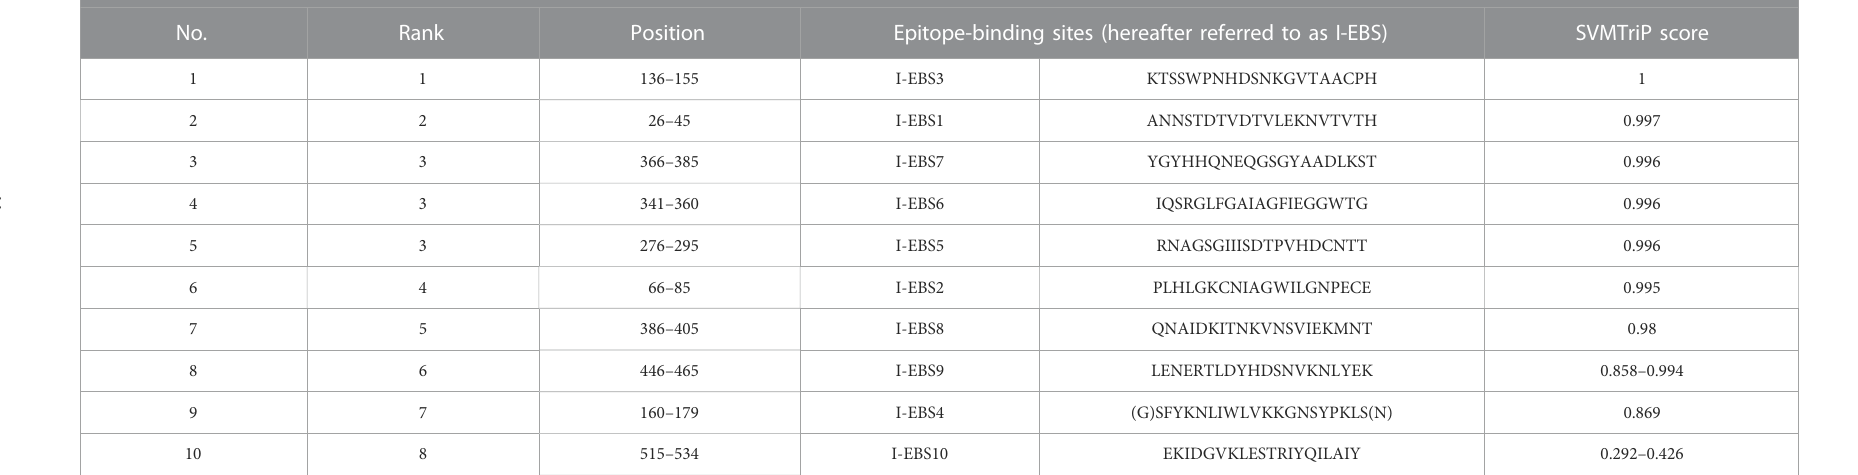
TABLE 5 Top 10 antigenic sites identi fi ed in HA Ind proteins using the SVMTriP server. Top 10 epitope-binding sites identi fi ed in HA Ind